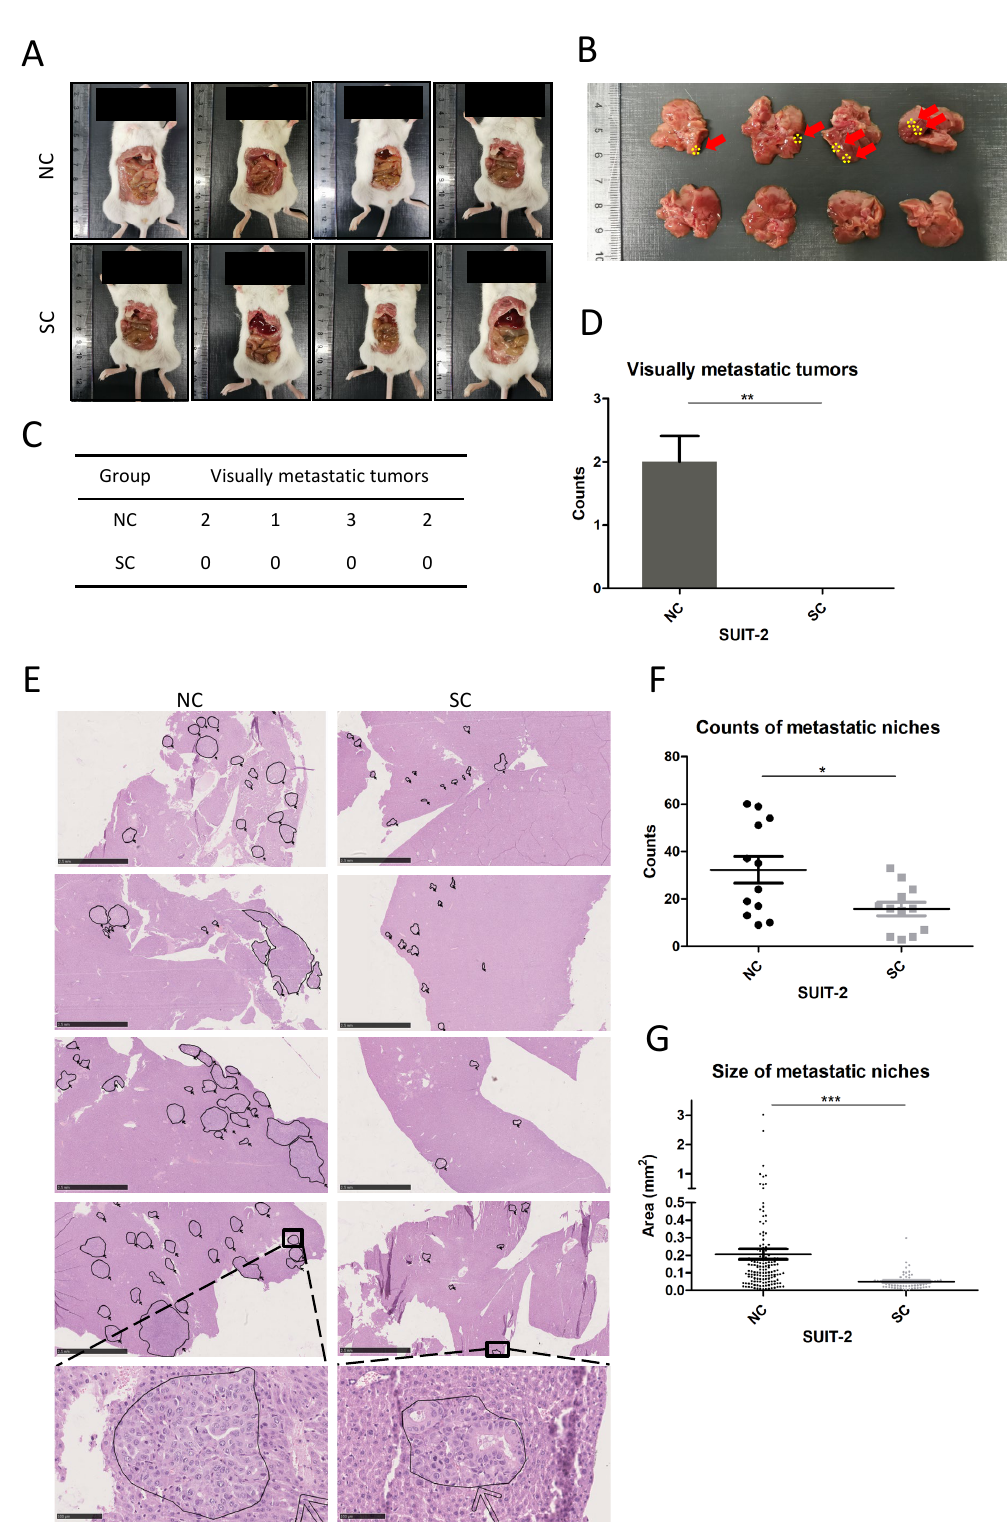
Figure 7. Knockout of PCSK6 inhibited liver metastasis in the tumor xenograft model of intrasplenic injection. ( A ) Overall explorations of the abdominal cavity in each group. ( B – D ) Macroscopic examinations of liver metastatic lesions in each group. ( E ) Microscopic view of HE sections, with identified liver metastatic niches in each group. Each metastatic niche was marked, and the area was calculated automatically. Scale bar = 2.5 mm. ( F ) Counts of liver metastatic niches in each group. ( G ) Sizes of liver metastatic niches in each